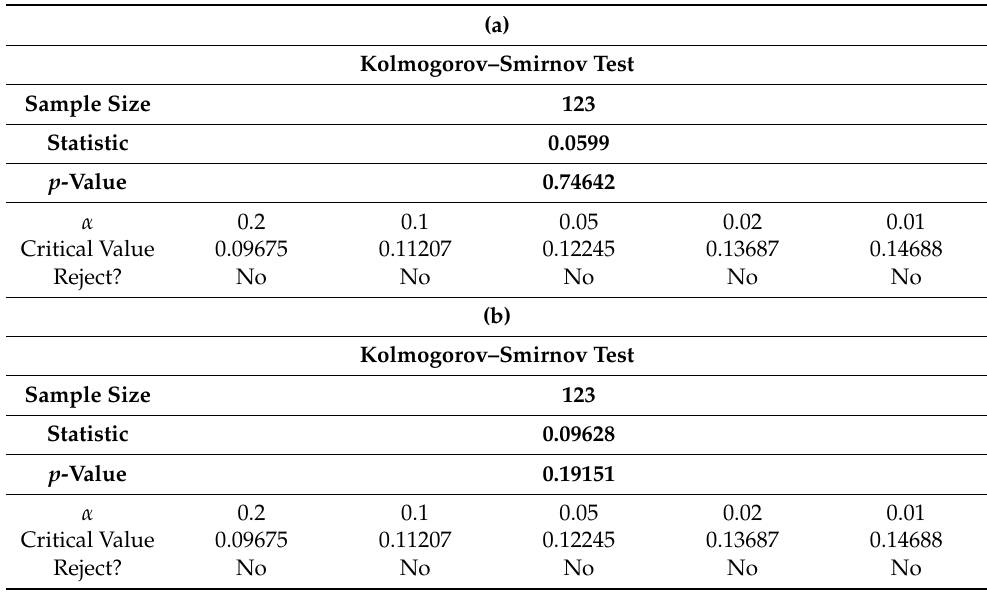
Table 3. The results of the Kolmogorov–Smirnov test of the ( a ) downtime and ( b ) timeout.